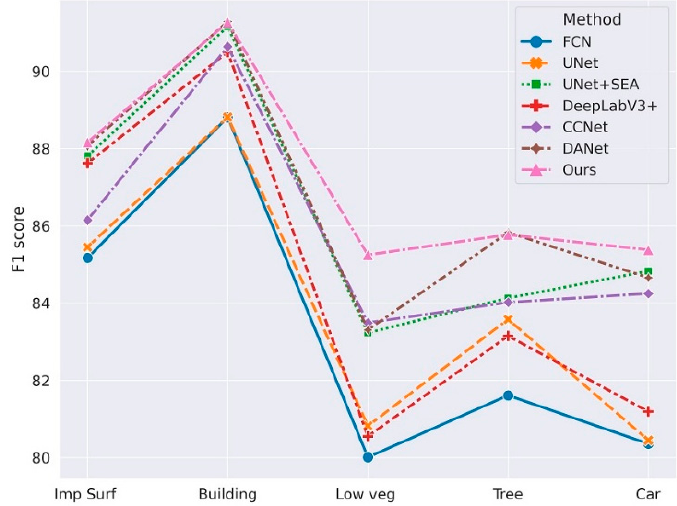
Figure 14. Qualitative comparisons between different methods applied to sample images.